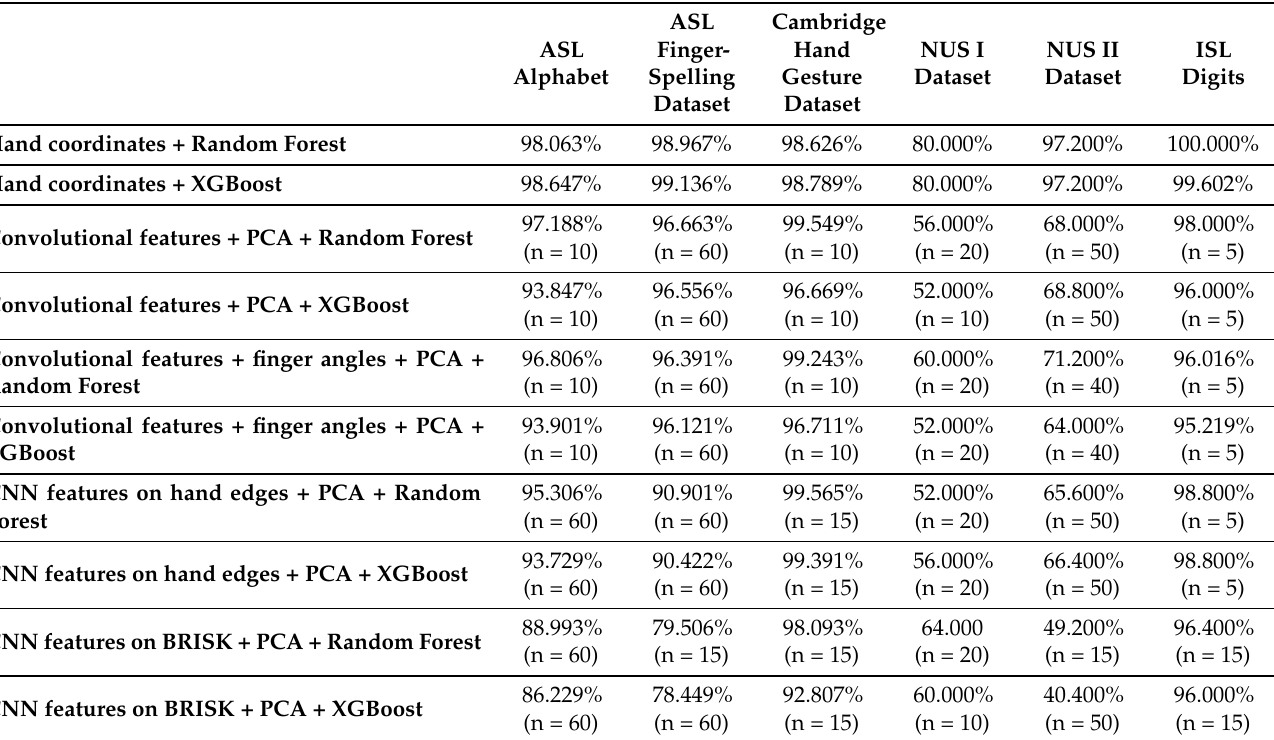
Table 10. Ensemble accuracies for different numbers of PCA components in convolutional-related features, and hand